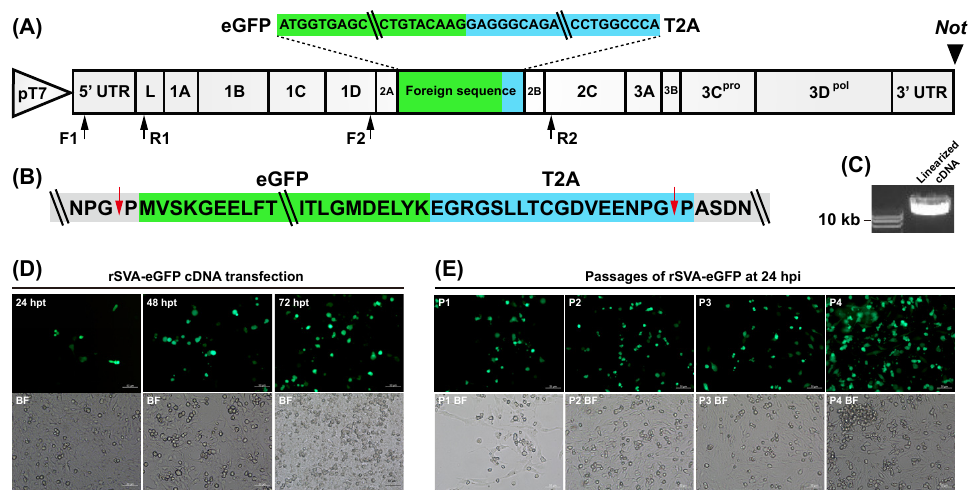
Figure 1. Construction of rSVA-eGFP cDNA clone for rescuing eGFP-expressing recombinant SVA. Schematic representation of rSVA-eGFP cDNA clone ( A ). The eGFP-T2A fusion sequence is inserted between the 2A and 2B genes in the backbone of rSVA cDNA clone, flanked by the T7 promoter and the Not I recognition sequences at its 5 (cid:48) and 3 (cid:48) ends, respectively. Two pairs of primers, F1 / R1 and F2 / R2 (black arrow-marked), are designed for RT-PCR analyses on rSVA-eGFP genome and on foreign sequence, respectively. Schematic representation of two self-cleavage sites (red arrow-marked) in the rSVA-eGFP polyprotein ( B ). Agarose gel electrophoresis of Not I-linearized rSVA-eGFP cDNA clone ( C ). The rSVA-eGFP cDNA clone-transfected BSR cell monolayers at 24, 48 and 72 hpt ( D ). BSR cell monolayers infected with the rescued rSVA-eGFP at P1, P2, P3 and P4 at 24 hpi ( E ). BF: bright field